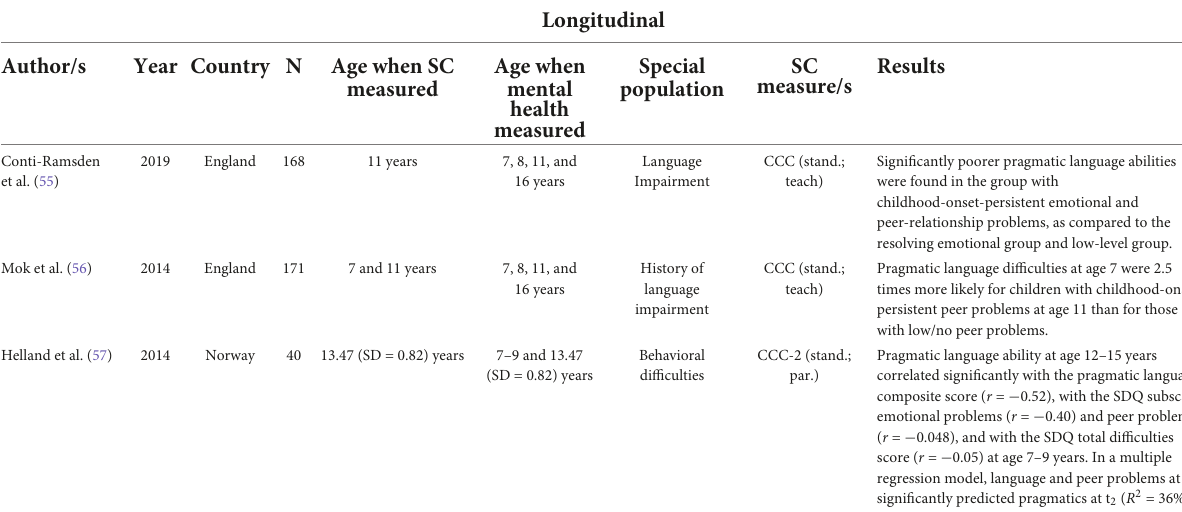
TABLE 4 Characteristics of special population longitudinal